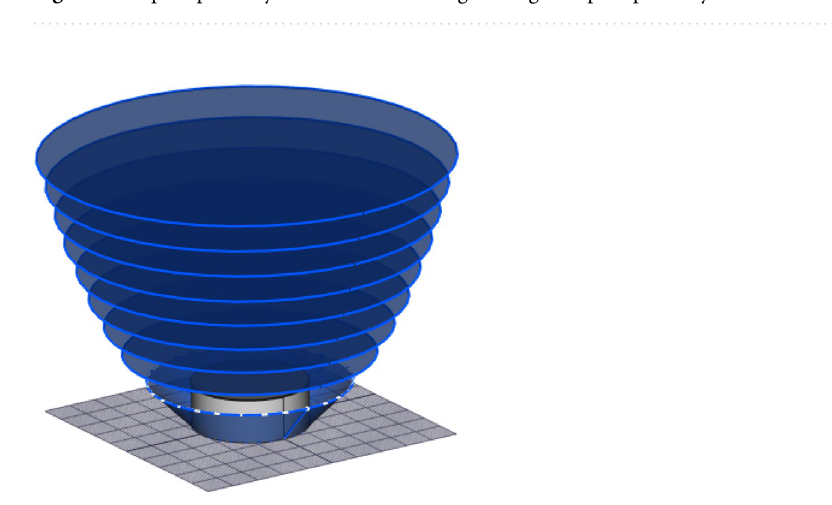
Figure 12. Space point layers above a FRT using rectangular space point layers.